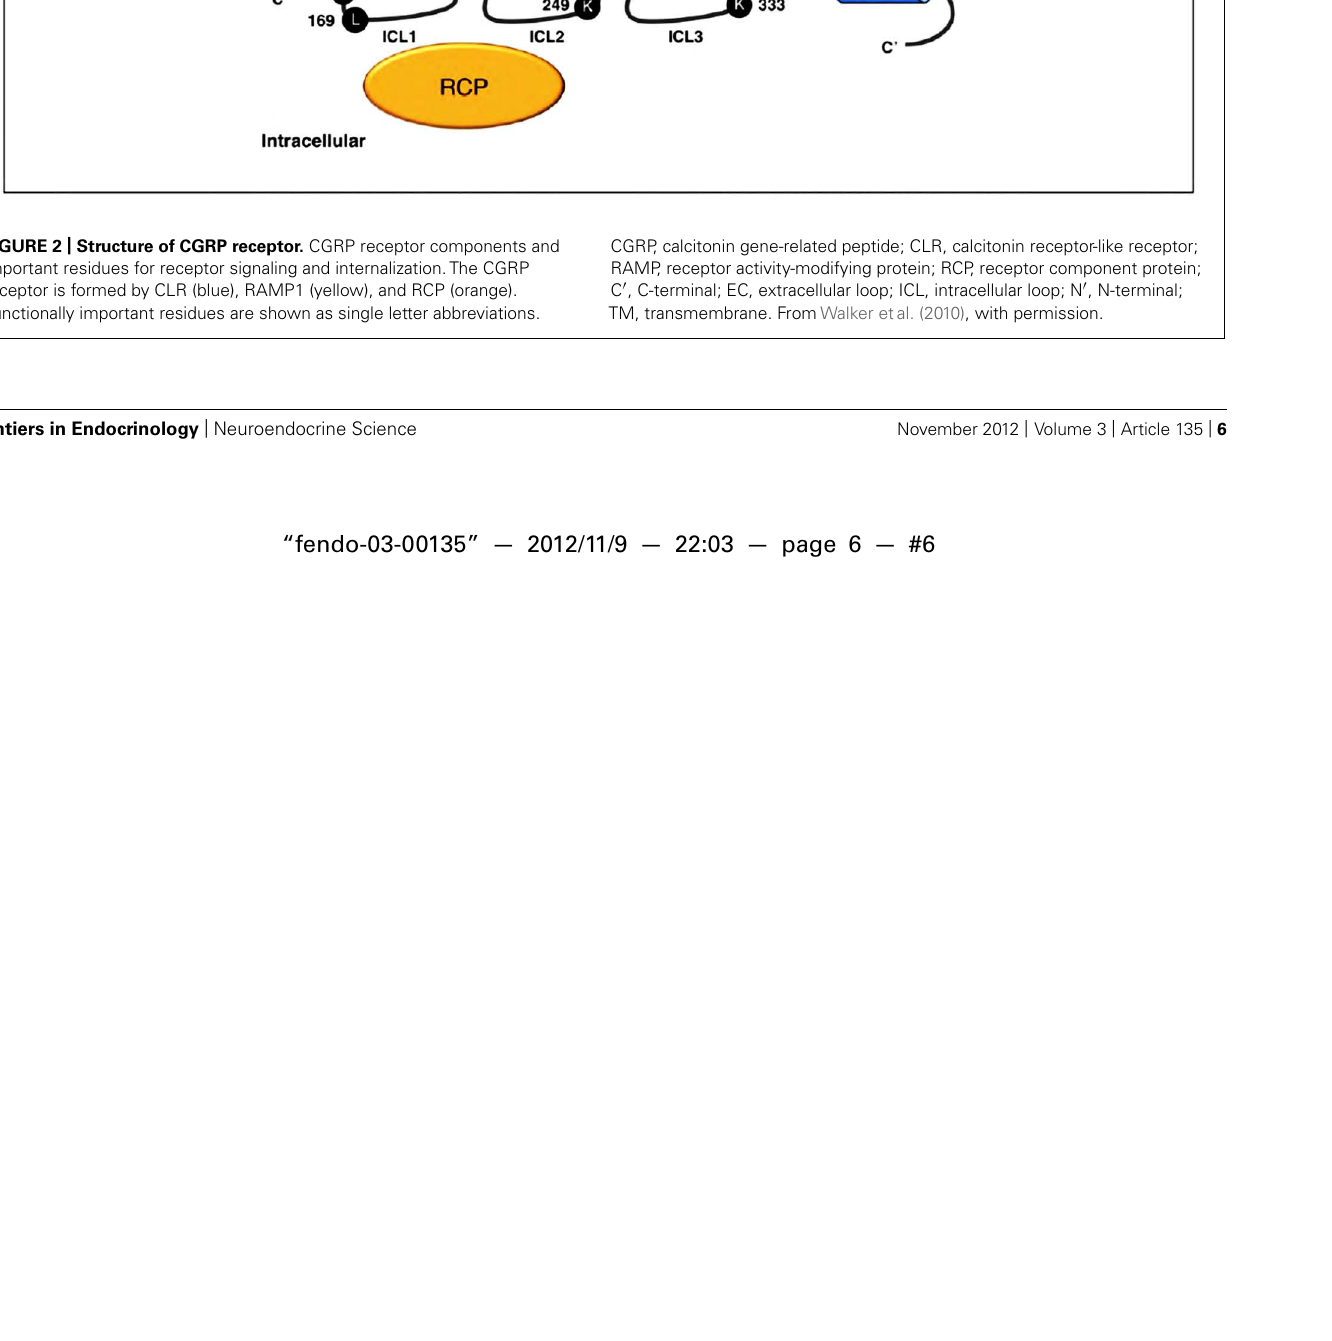
FIGURE 2 | Structure of CGRP receptor. CGRP receptor components and important residues for receptor signaling and internalization.The CGRP receptor is formed by CLR (blue), RAMP1 (yellow), and RCP (orange). Functionally important residues are shown as single letter abbreviations.